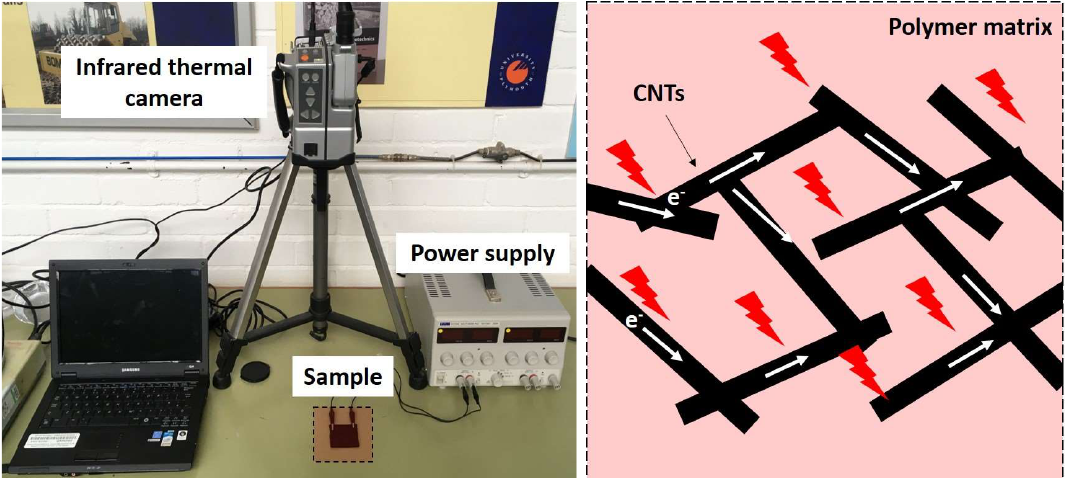
Figure 1. Experimental set-up for the fabrication of carbon nanotube (CNT) nanocomposites cured by Joule heating.